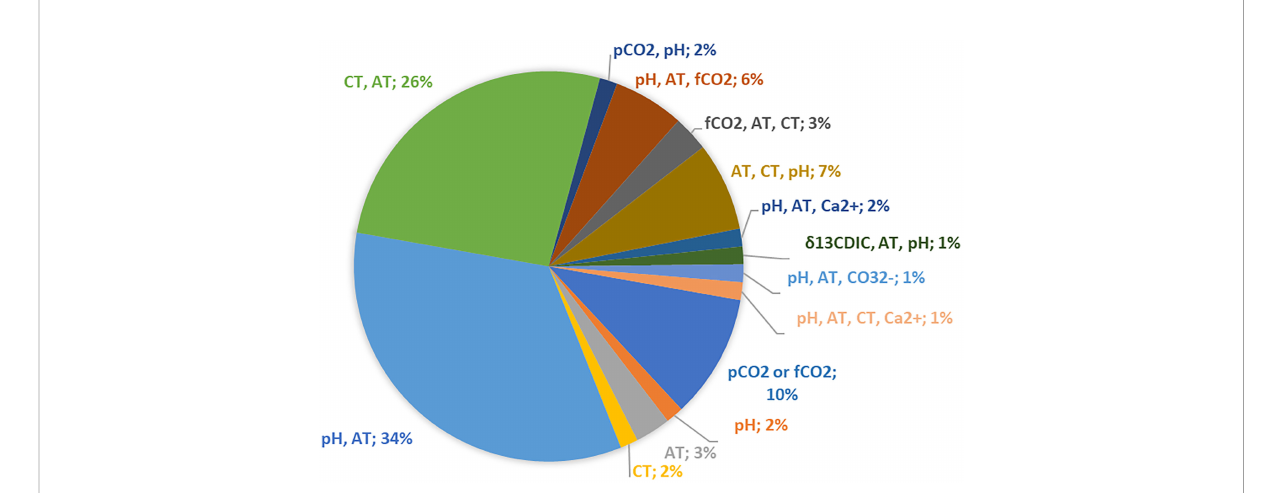
FIGURE 6 The measured parameters used to constrain the carbonate system in OA biogeochemical